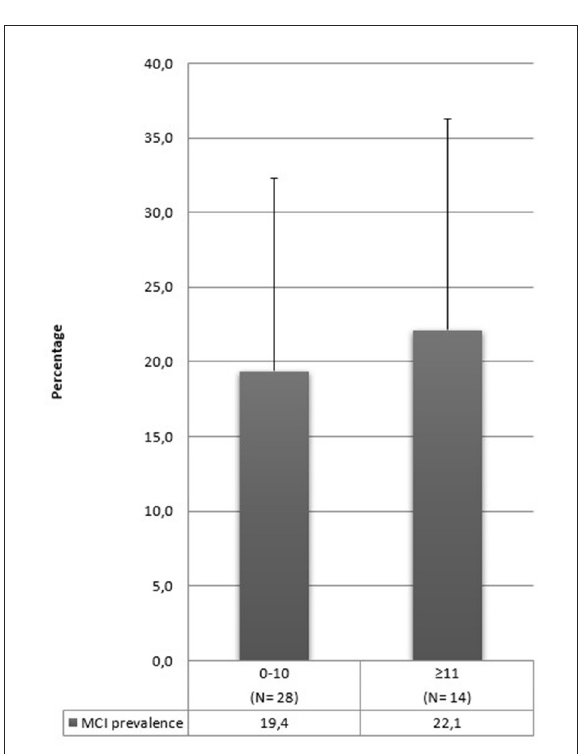
FIGURE3 MCI mean prevalence rates according to schooling years.